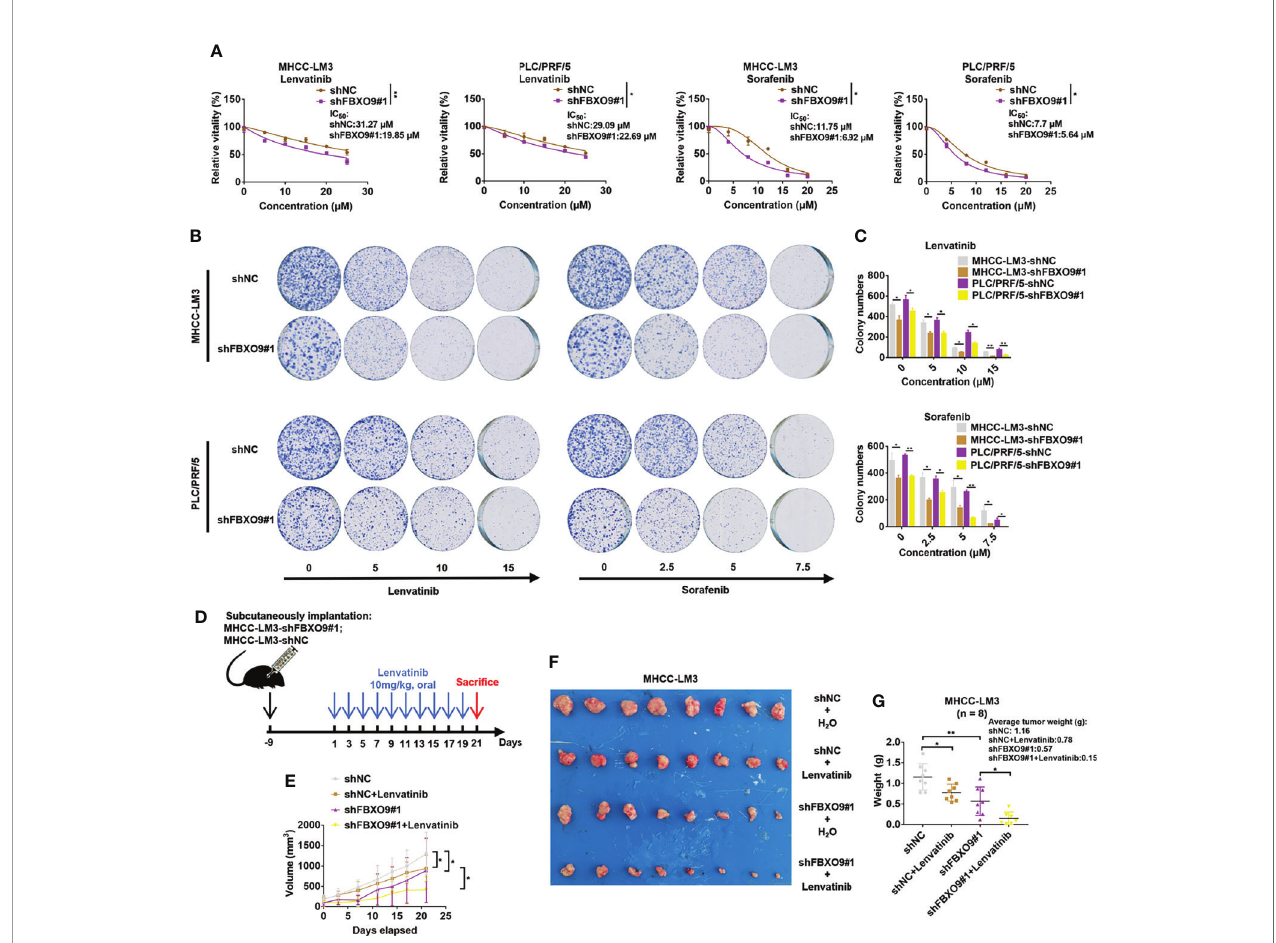
FIGURE 6 | Knockdown of FBXO9 increases chemosensitivity of HCC cells. (A) FBXO9 knockdown HCC cells were treated with Lenvatinib (0 – 25 µM) or sorafenib (0 – 20 µM) for 72 h and cell viabilities were assayed. (B) Effects of lenvatinib and sorafenib on MHCC-LM3 cells with FBXO9 knockdown were analyzed by using long-term colony-formation assays. (C) Quantitative analysis of colony-formation assays. (D, E) MHCC-LM3-shFBXO9#1/MHC-LM3-shNC cells were subcutaneously injected into nude mice. After 10 days of tumor formation, the mice were treated with 10 mg/kg lenvatinib orally every other day, and the tumor growth curves of mice were analyzed. (F, G) Both lenvatinib treatment and FBXO9 knockdown inhibited tumor growth, and FBXO9 knockdown combined with lenvatinib treatment more effectively abolished tumor growth in mice (n = 8). Error bars are shown as the mean ± SD, n = 3. *, P < 0.05; **, P < 0.01 by two-tailed Student t -test or one-way